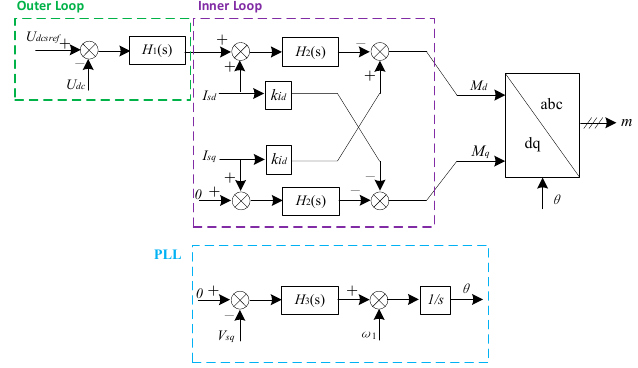
Figure 5. DC-voltage control structure of MMC.